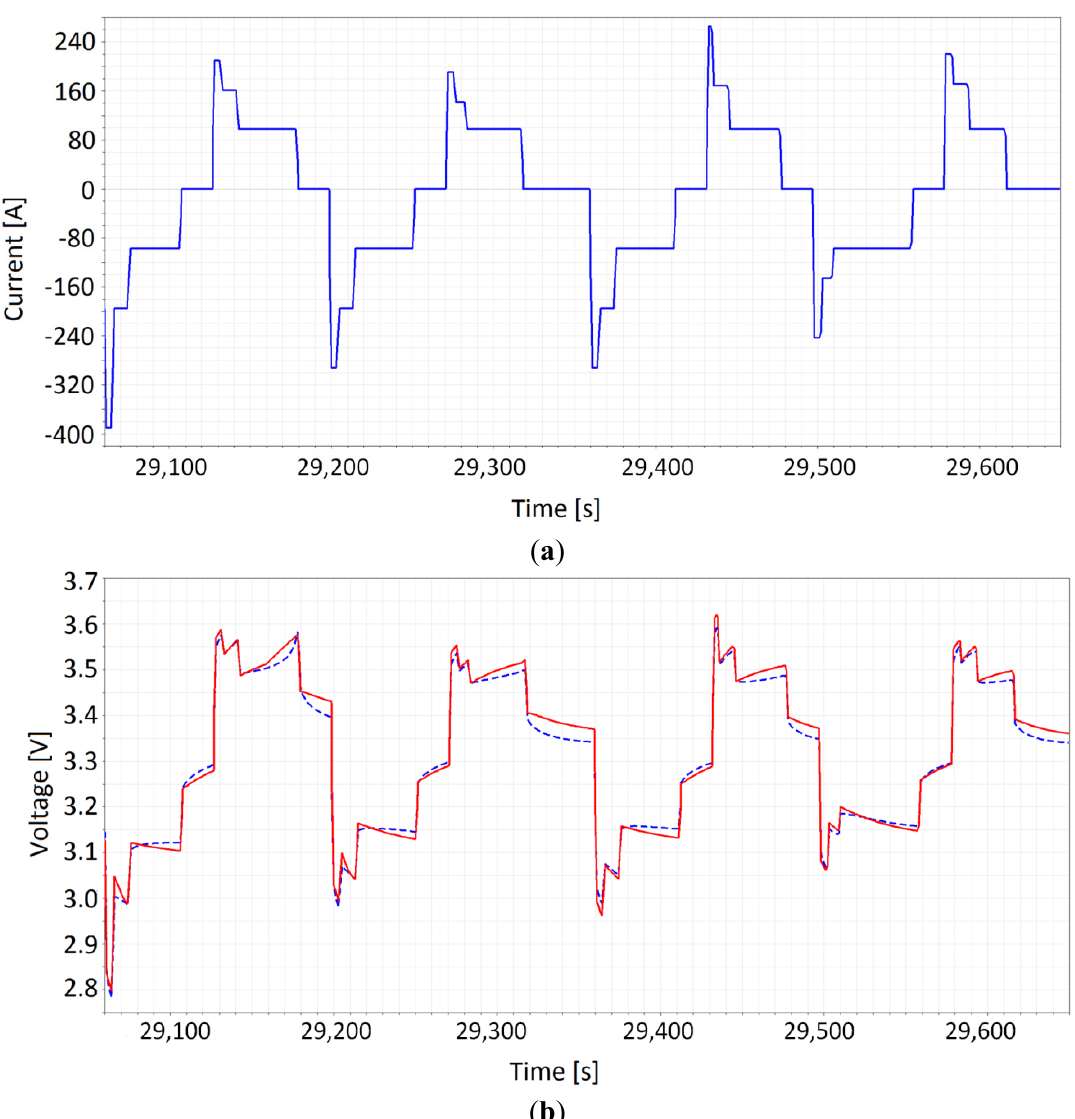
(LFP) cell. The maximum transient error is less than 50